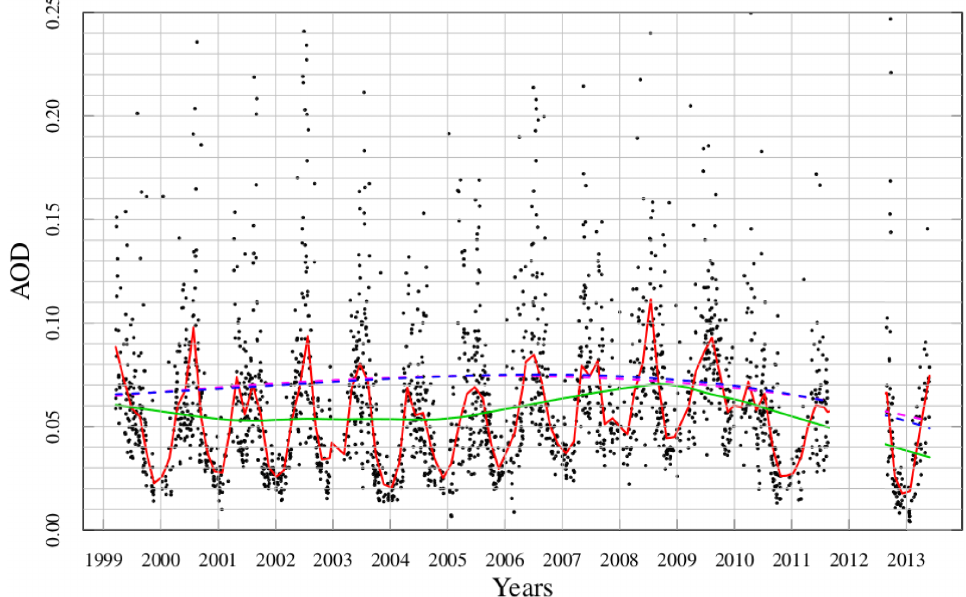
Figure 2. Black dots are 2252 daily averages of AOD at 500nm. The red line is a loess fit with a 3-month window. The green line is a loess fit with a 5-year window. The blue dashed line is a least squares fit to a cubic polynomial. A year gap in the vis-MFRSR measurements occurred in 2011–2012. This interruption in vis-MFRSR operation was due to structural renovations at the SPL facility.